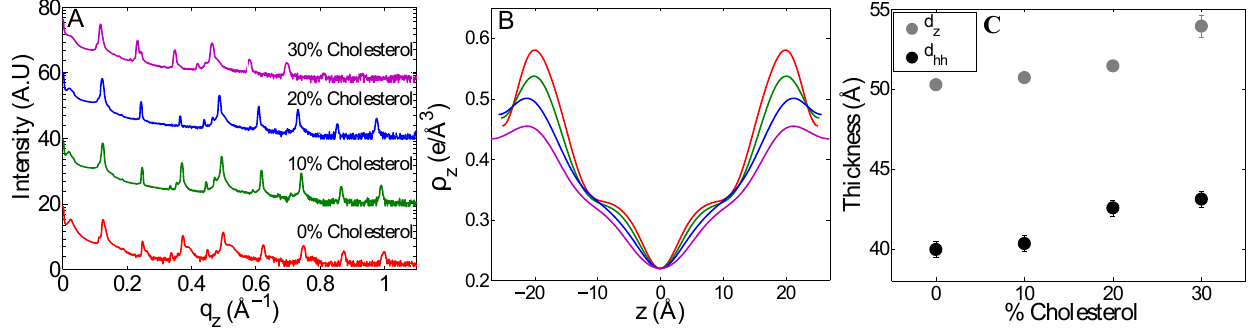
Effect of cholesterol on the lamellar spacing and thickness of mitochondria-like membranes. ( A ) Reflectivity curves for mitochondria-like membranes with 0, 10, 20 and 30 mol% cholesterol. The curves are shifted vertically for clarity. Intensity is plotted on a logarithmic scale. ( B ) Scaled electron density profiles of mitochondria-like membranes with the same cholesterol content as in (A). ( C ) Lamellar spacing, d z , and peak-to-peak membrane thickness, d hh , as a function of cholesterol